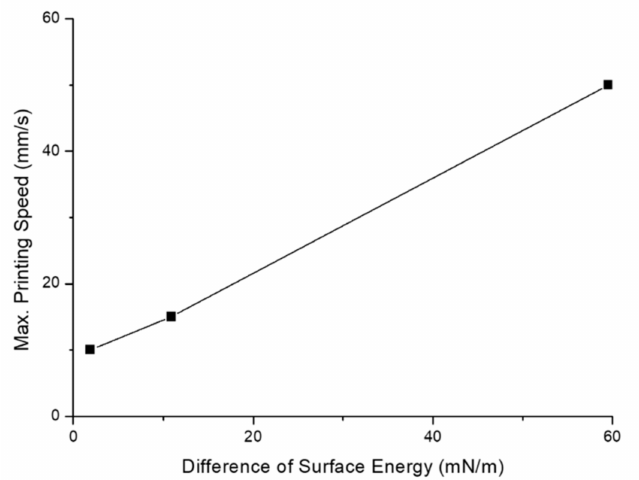
Figure 7. Maximum allowable printing speed according to the surface energy difference between the blanket and the flexible clich é